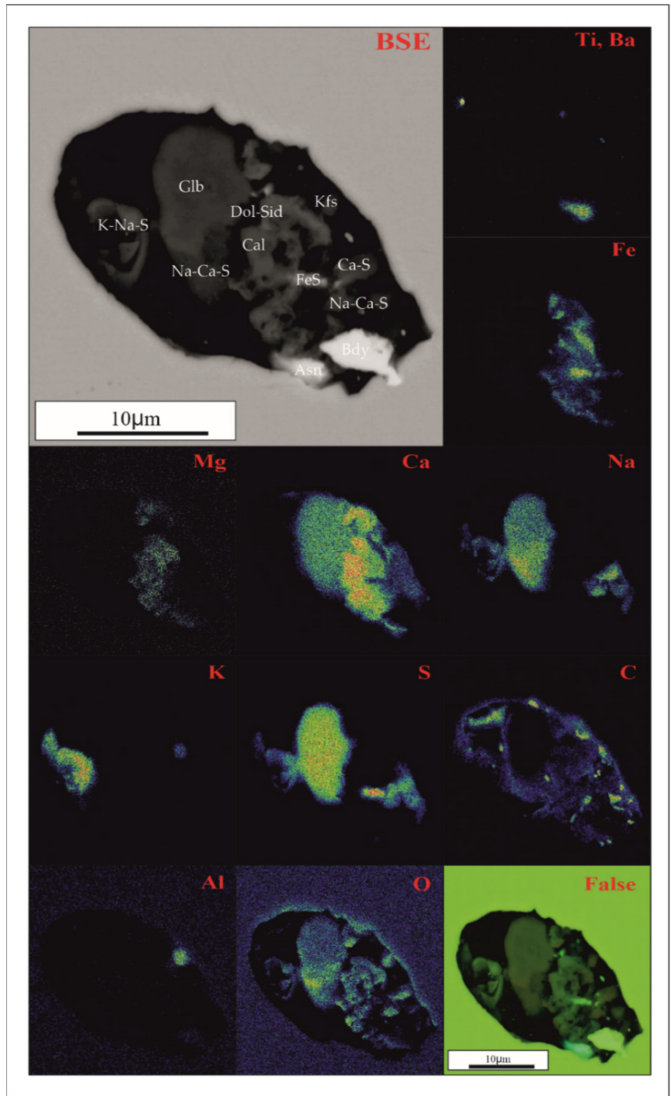
Figure 7. BSE image and elemental maps for a sulphate-carbonate inclusion in the Le Fosse di Novale zircon, grain VR2-2. Symbols: Bdy—baddeleyite; Asn—BaCa(CO 3 ) 2 mineral (alstonite, paraalstonite or barytocalcite); Glb—glauberite Na 2 Ca(SO 4 ) 2 ; Dol-Sd—dolomite–siderite; Cal—calcite;